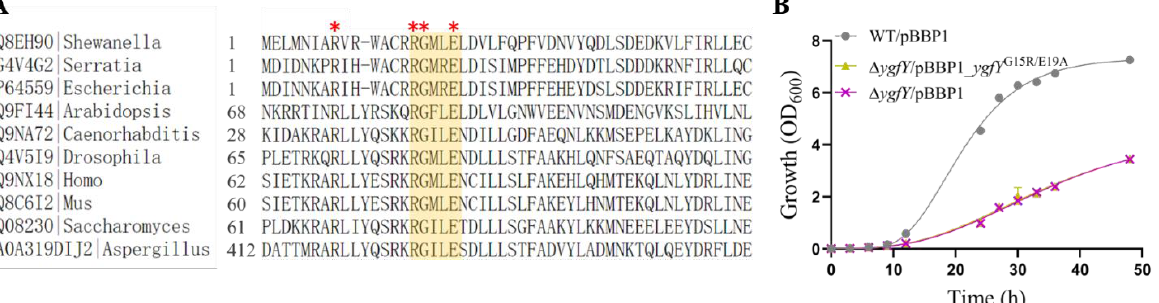
Figure 6. Conserved sites essential for YgfY activity. ( A ) Amino acid alignment of succinate dehydrogenase flavinylation factors and YgfY homologs. Entry of proteins in Uniport and family of organisms are indicated. Red asterisk (*) indicate conserved amino acid residues and RGXXE motif is highlighted with a yellow box. ( B ) Growth of ∆ ygfY complemented with YgfY mutant (YgfY G16R/E19A ). The data are the mean ± SD ( n = 3). Error bars for some data points were too small to be shown.